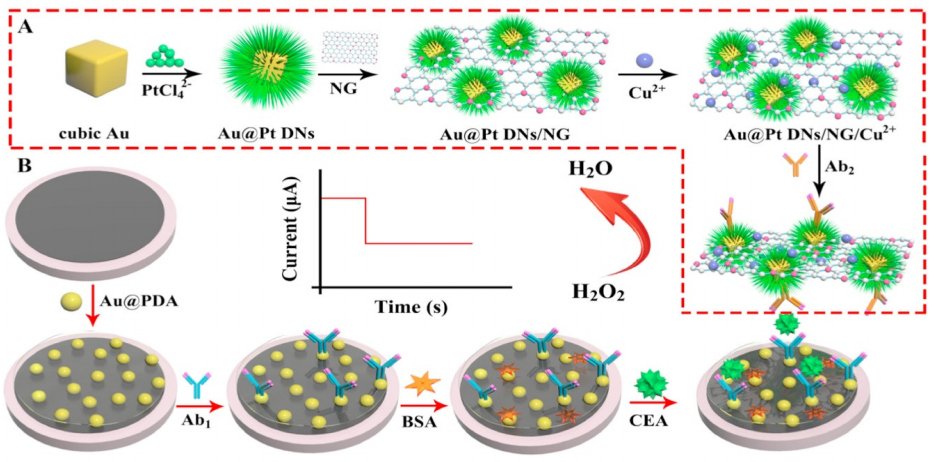
Figure 15. The preparation process of Au@Pt DNs/NG/Cu 2+ –Ab2 and schematic illustration of the sandwich–type EC immunosensor. ( A ): Probe preparation process; ( B ): Electrode modification process for the capturing of antigen and probe. Au@PDA: polydopamine doped Au nanoparti- cles; Au@PtDNs: cubic Au doped with Pt dendritic nanomaterials; NG: nitrogen–doped